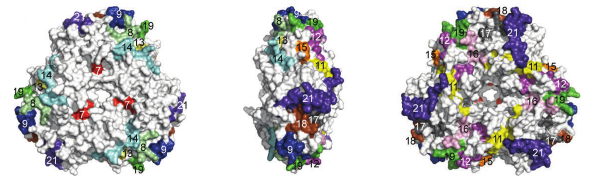
Figure 1: IgE epitopes are mapped on the surface of the 3D model of Ara h 1 core region [16].